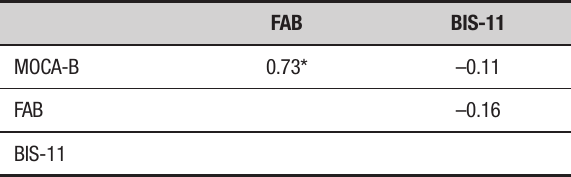
Table 3. Pearson’s Correlation